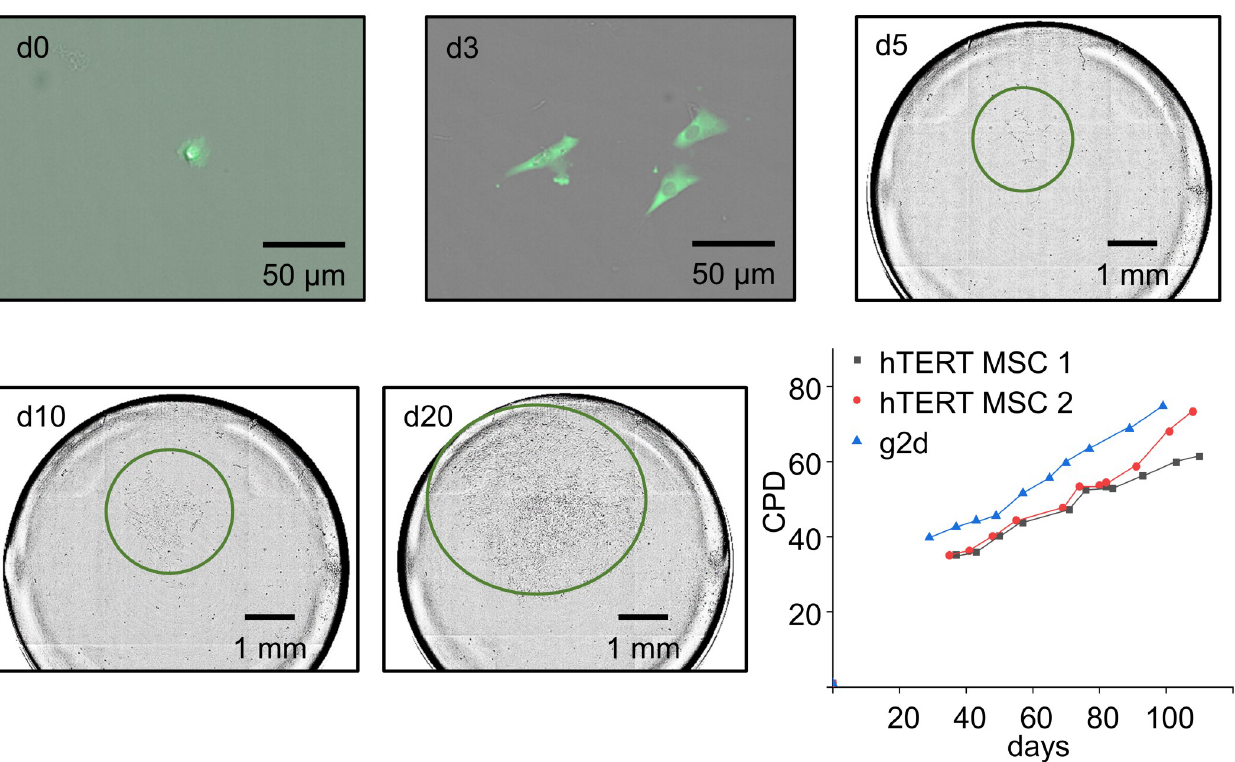
Fig 3. Colony growth of isolated single-cells. The colony growth was recorded with the NyOne ™ imager. On day 0 (d0) after printing, the clonality of cells was screened by fluorescent-activated single-cell colony mode (FASCC) and positive wells were marked. During the course of 20 days, FASCC was used until day 3, but from day 5, due to loss of fluorescence, only brightfield single-cell colony mode (SCC) was used and recorded at 5, 10, and 20 days. Colonies are highlighted by green circles. The growth rates of two control hTERT MSC clones and one hTERT MSC RANKL/KO clone (g2d) were tracked for 100–120 days after initial single-cell isolation and CPDs are